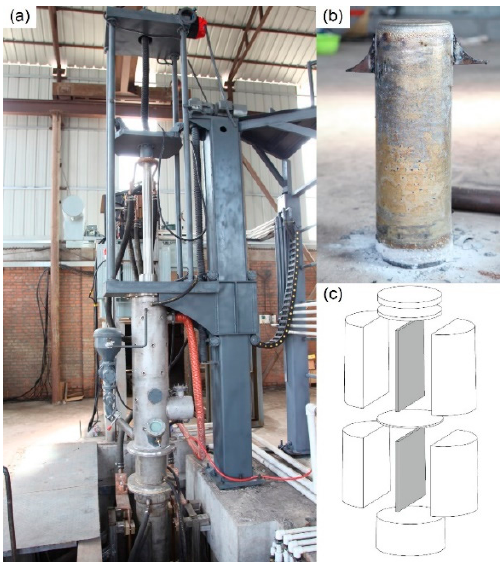
Figure 5. Photos of the experiment: ( a ) 200 kg argon protection ESR furnace; ( b ) ESR ingot; ( c ) Illustration of wire cutting on ESR ingot, the longitudinal section labelled by gray color is used for the current study.